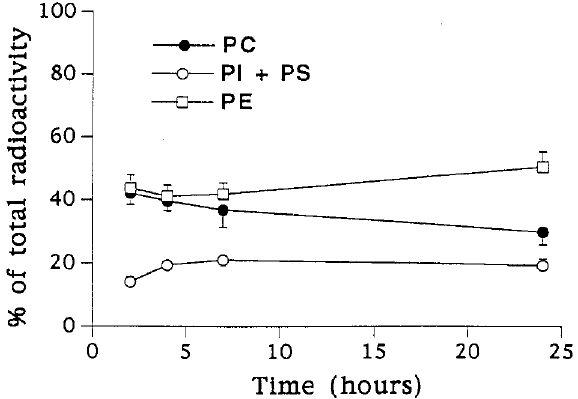
FIG. 3. Release of [ 3 H]-AA by bone marrow mononuclear cells. Labelled cells were stimulated with GM-CSF (100ng/ ml) at 37°C for various periods of time. Radioactivity in cell supernatants was measured on a liquid scintillation counter. Mean ± SEM of three independent experiments. * P < 0.05 compared with controls (Mann-Whitney U